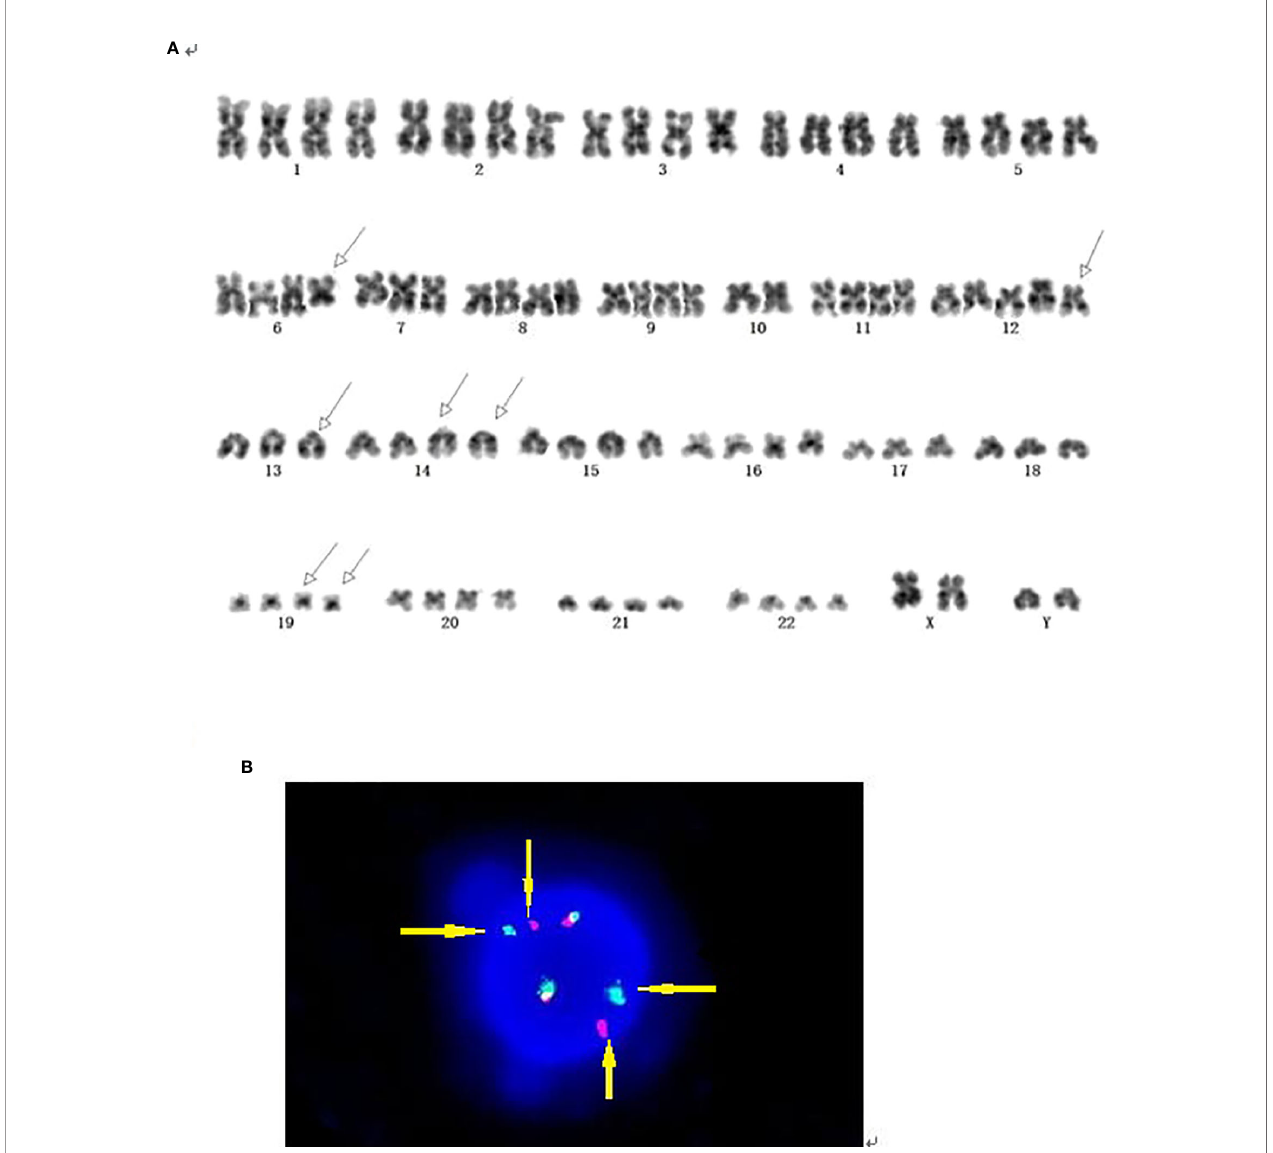
FIGURE 1 | (A) G-banding analysis of case 2 showed t(14;19) accompanied by a complex.karyotype of near-tetraploid with concurrent 6q deletion and +12. (B) Interphase FISH analysis of case 2 using the dual-color BCL3 probe. FISH results demonstrated two intact red/green fusion signals, and 2 red and 2 green split signals, which indicated BCL3 gene break-apart. (Yellow arrows pointed to split signals of the rearranged